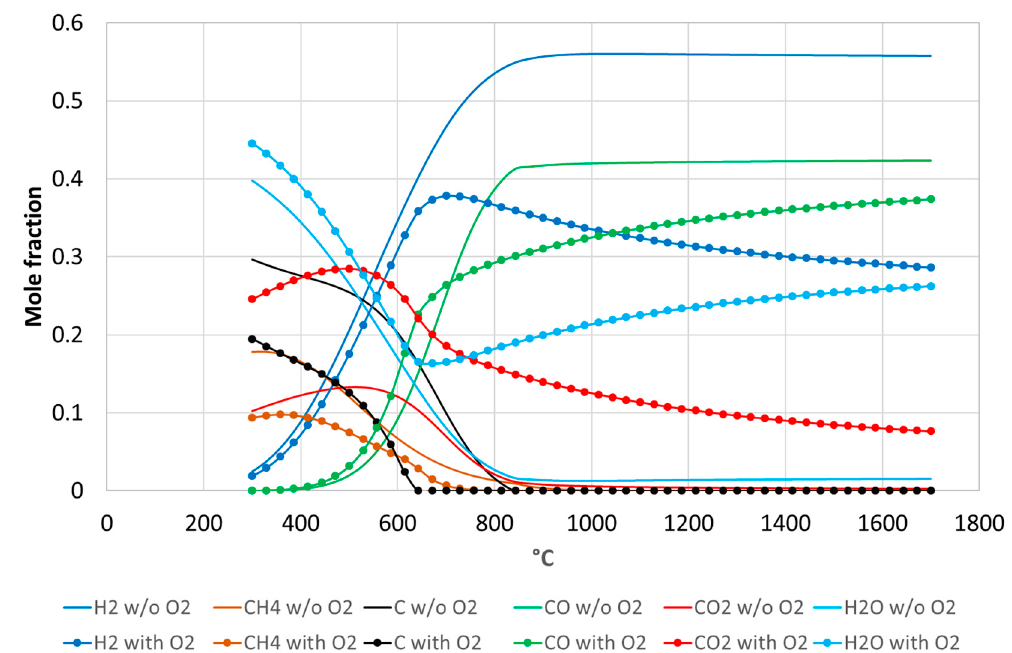
Figure 8. Thermodynamic equilibrium calculation for the chemical system compositions corresponding to Run#3 (without O 2 , initial composition for calculation: C = 0.026 mol, H 2 = 0.035 mol, O 2 = 0.014 mol) and Run#4 (with O 2 , initial composition for calculation: C = 0.027 mol, H 2 = 0.033 mol, O 2 = 0.023 mol) at 1 bar.